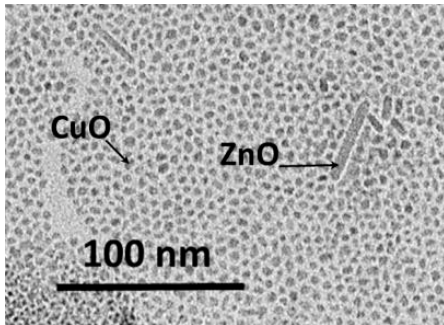
Figure 2. TEM image of CuO 75% /ZnO 25%